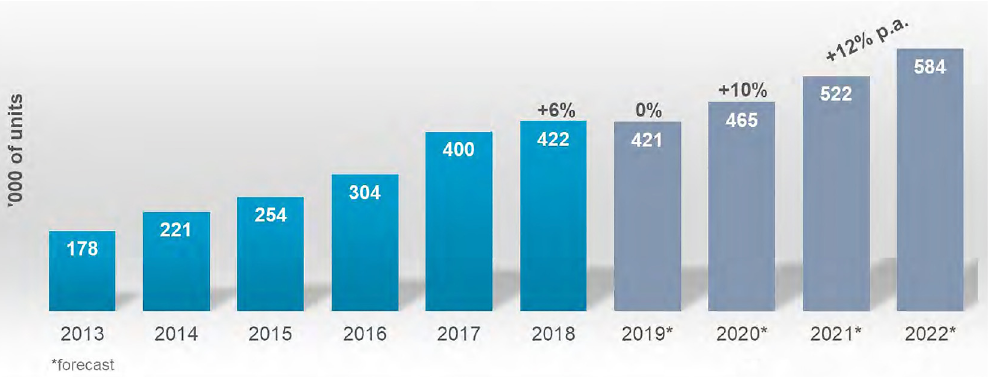
Figure 1: Annual installations of industrial robots 2013 – 2018 and 2019* – 2020*, IFR [ 6 ] .